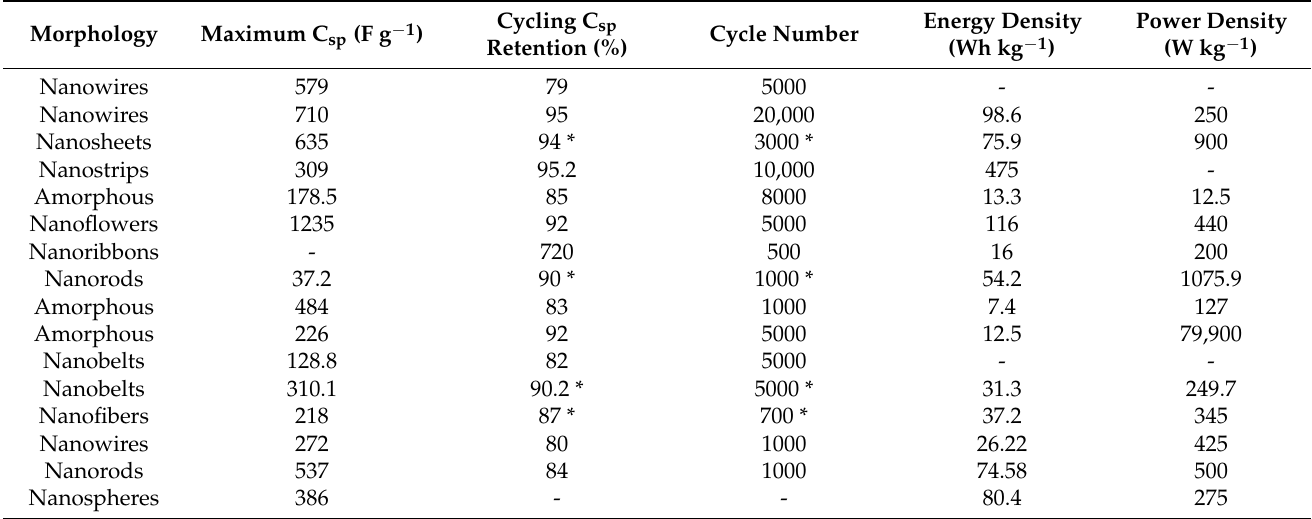
Table 1. V 2 O 5 morphology and electrochemical performances of V 2 O 5 /reduced graphene oxide composite electrodes for supercapacitor